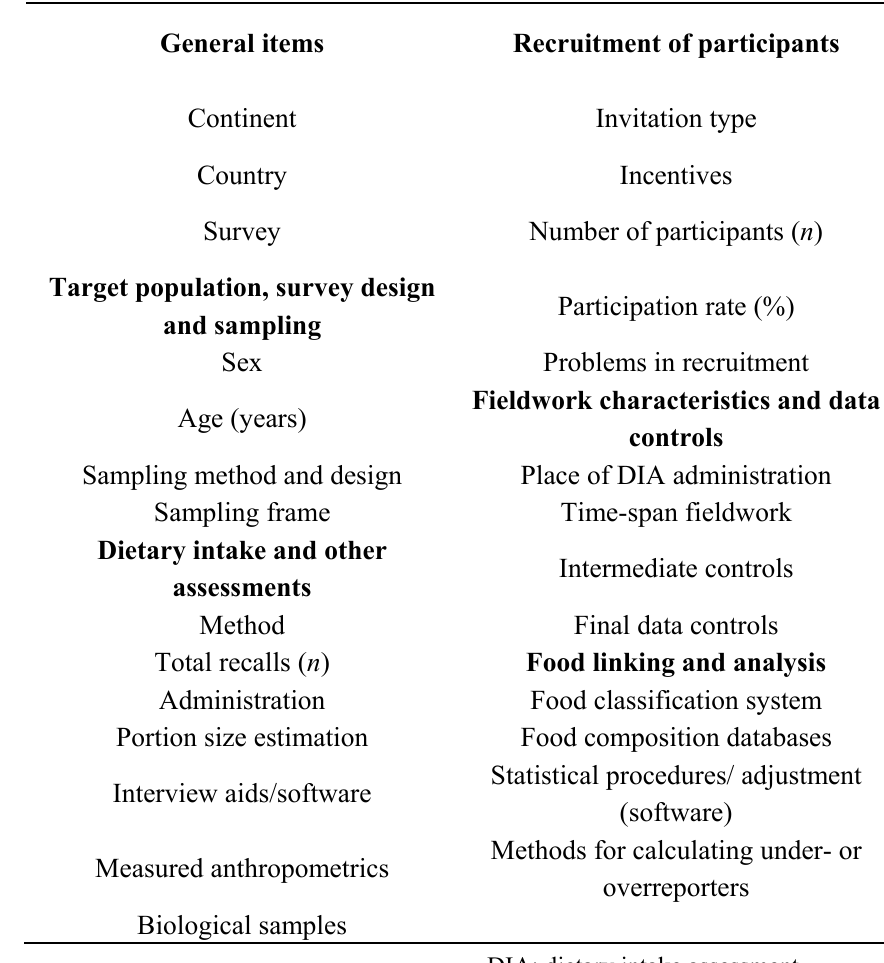
Table 1. Overview of inventory